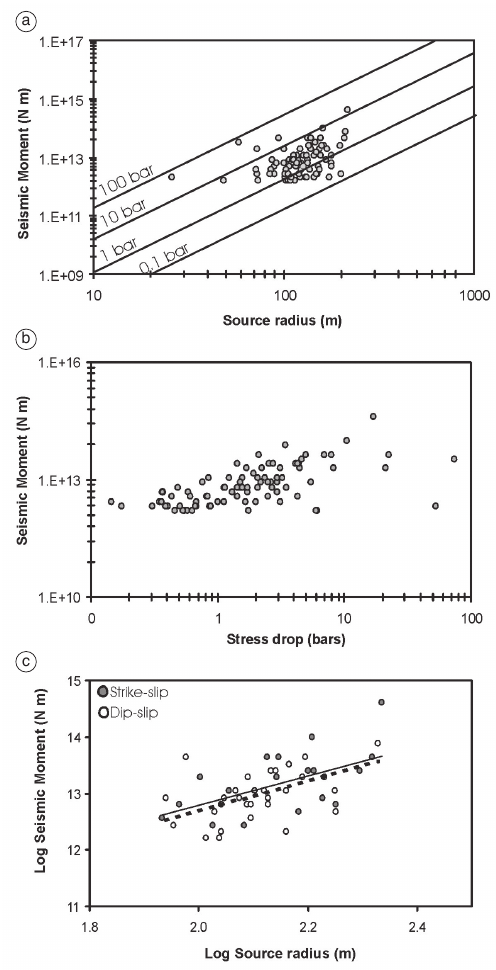
Fig. 7a-c. a) Seismic moment vs. source dimen- sions. The lines of constant stress drop are also re- ported. b) Seismic moment vs. stress drop. c) Scaling relations seismic moment-source radius for dip-slip (black line) and strike-slip (black dotted line) source